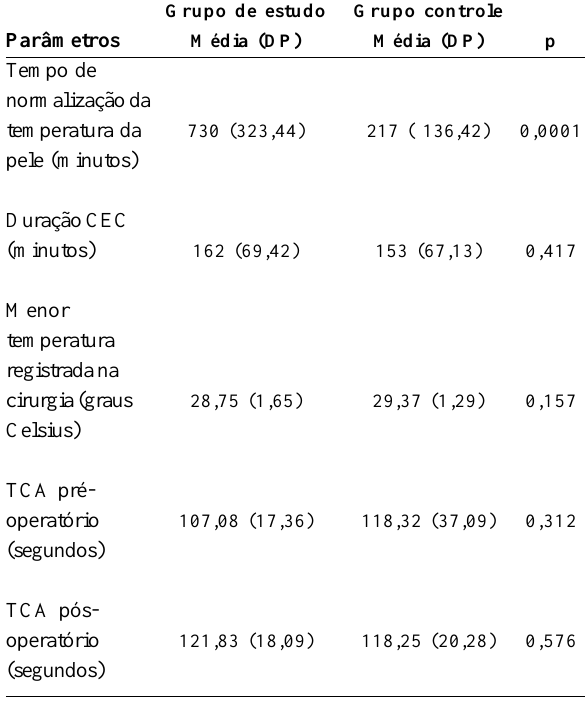
Tabela 1. Comparação dos parâmetros entre os grupos de